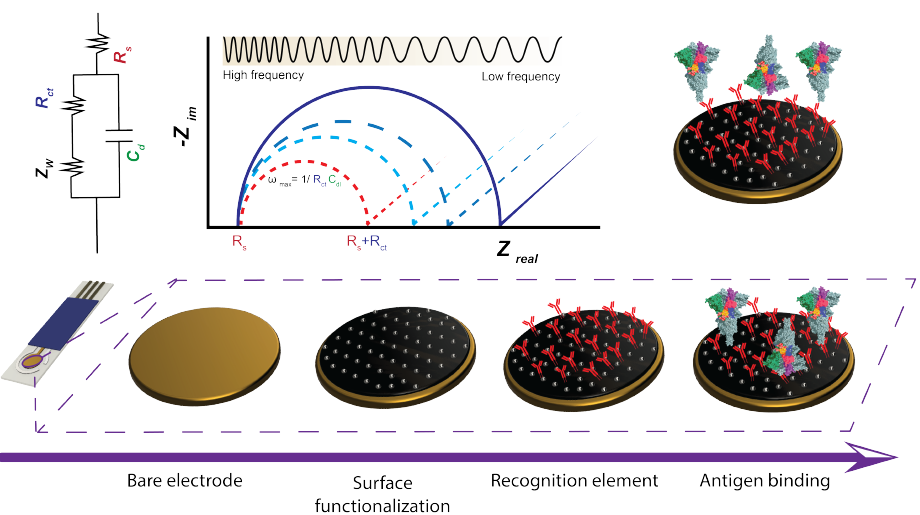
Figure 1. The general concept of electrode fabrication and its effect on a Nyquist plot. Bare electrodes are functionalized, a recognition/capture element is added, and the sensor is exposed to the target. In general, more mass bound to the surface of the electrode increases the semicircular diameter of the Nyquist plot, which is correlated to an increase in R ct in the Randles circuit. However, certain surface modifications can decrease the R ct transfer due to electrostatic interaction at the